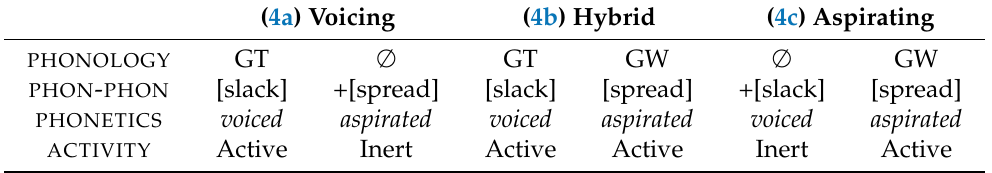
Table 4. Potential Frisian-English representations, with completions and activity for